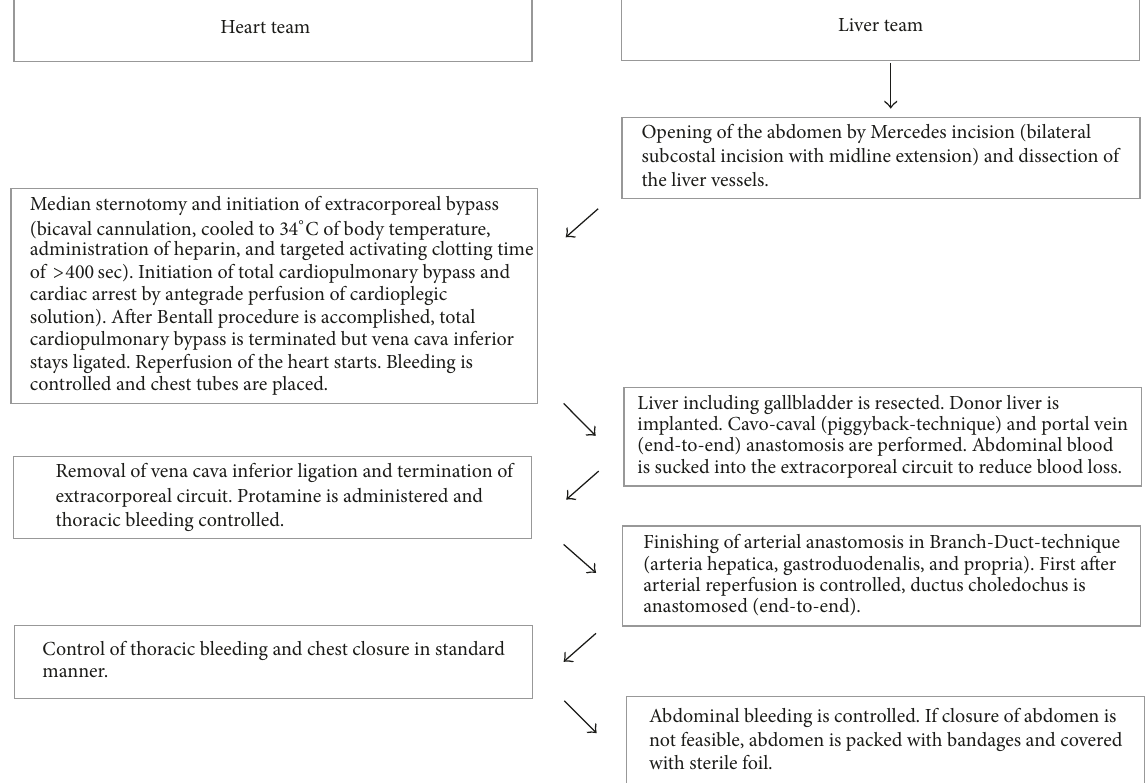
Figure 2: Surgical strategy of combined OLTx and Bentall operation. OLTx, orthotopic liver transplantation.